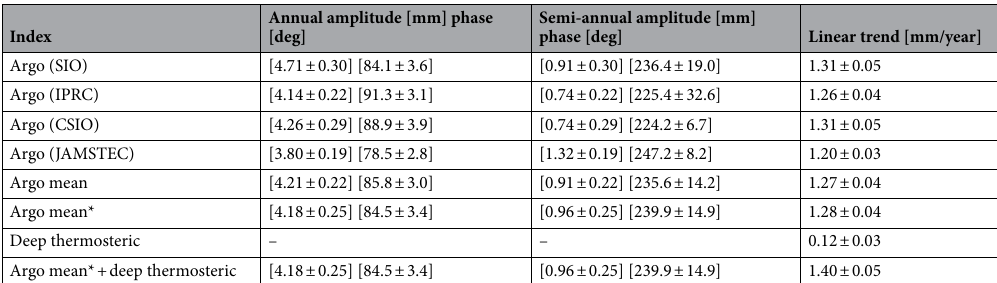
Table 3. Amplitudes of annual and semiannual components and linear trends of global mean thermosteric sea-level change from four Argo observations for the period January 2005 to December 2019. The uncertainty represents the least-squares fitting error (1 sigma for amplitudes, phases and trends). The same missing months as GRACE/GRACE-FO data are deleted from Argo observations, the corresponding re-estimated results are given as